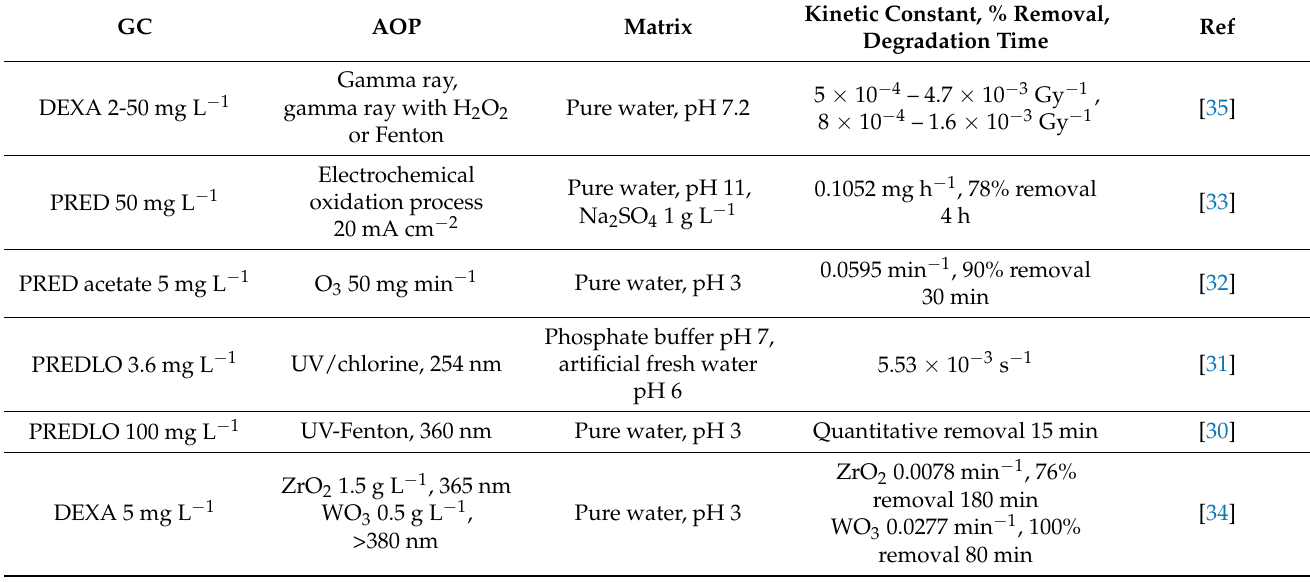
Table 3. Degradation constants ( k deg ) for each GC (10 mg L − 1 ) in tap water under simulated sunlight (see Paragraph 2.3 for the irradiation conditions) and comparison with other